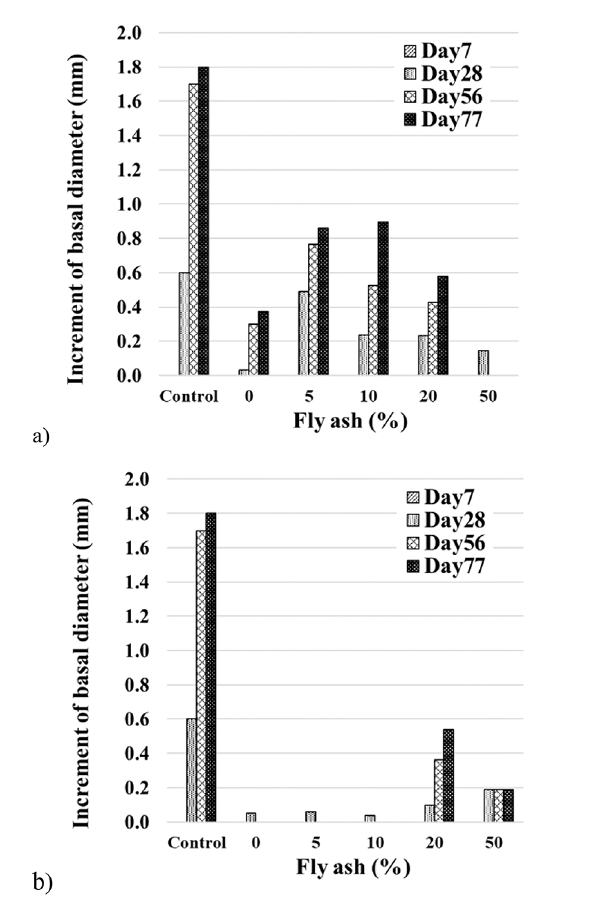
Fig. 2 Increment of basal diameter: a Acidic soil 1, b Acidic soil 2 Table 5 The metal accumulation in the plant body